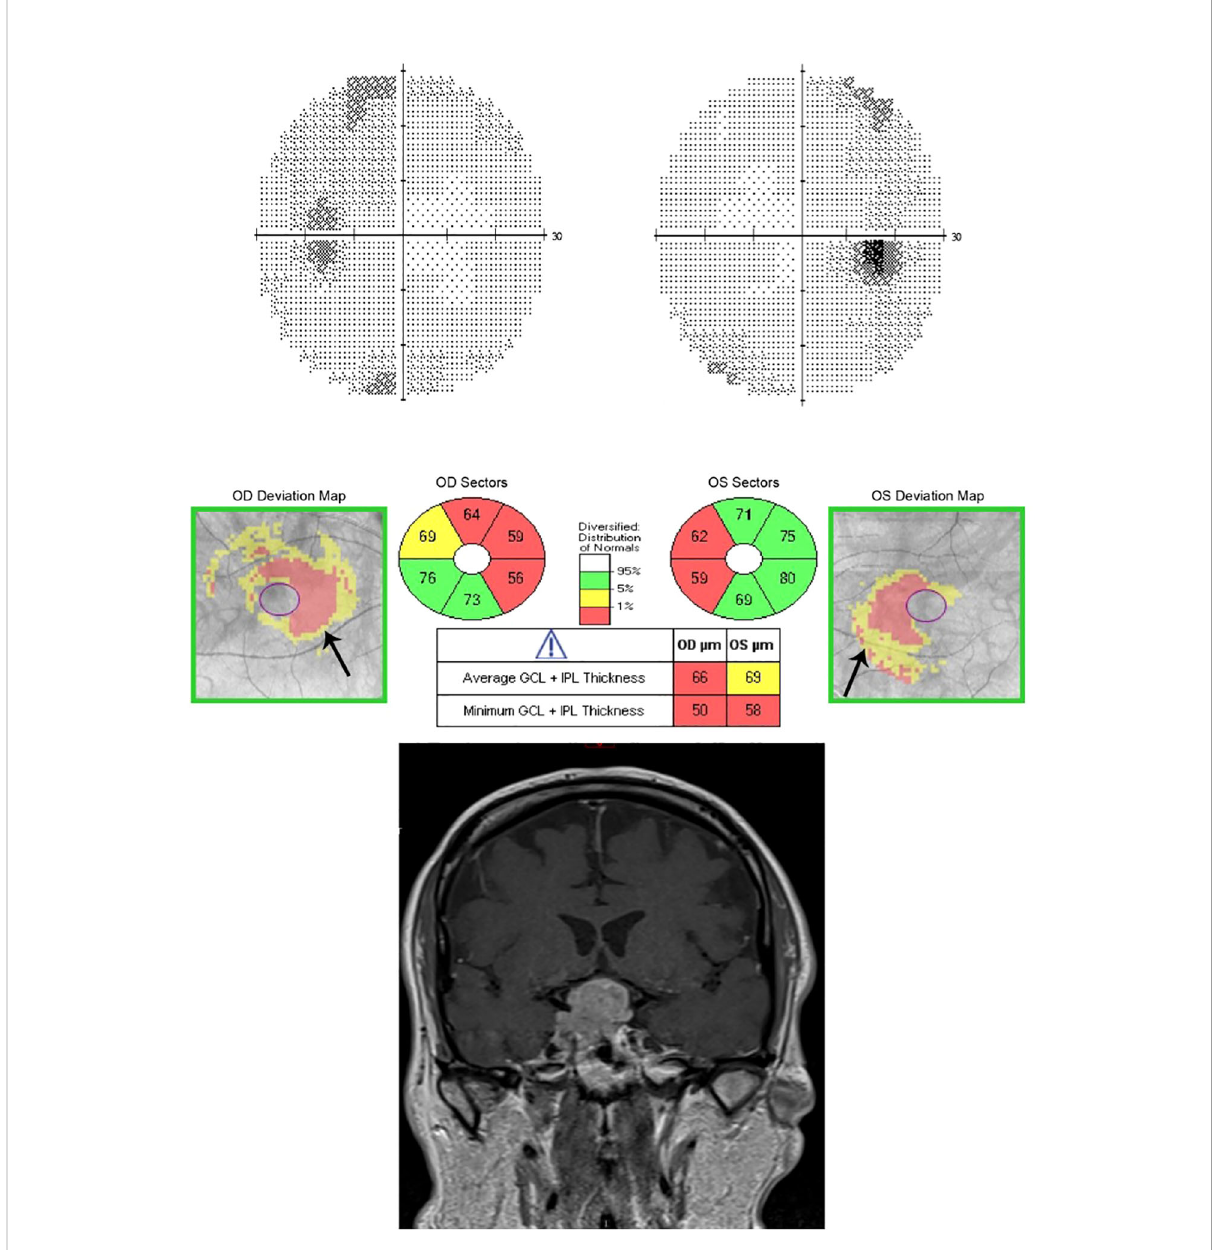
FIGURE 1 The sensitivity of OCT to detect GCC loss even before visual fi elds became abnormal for a patient with pituitary adenoma. (Top) Humphrey visual fi eld 24-2 without changes detected in this patient with pituitary macro adenoma. (Middle) Ganglion Cell Analysis of Spectral-domain OCT (Cirrus) showing binasal thinning in the GCC layer despite normal visual fi elds. (Bottom) MRI T1 coronal view with contrast showing pituitary macro